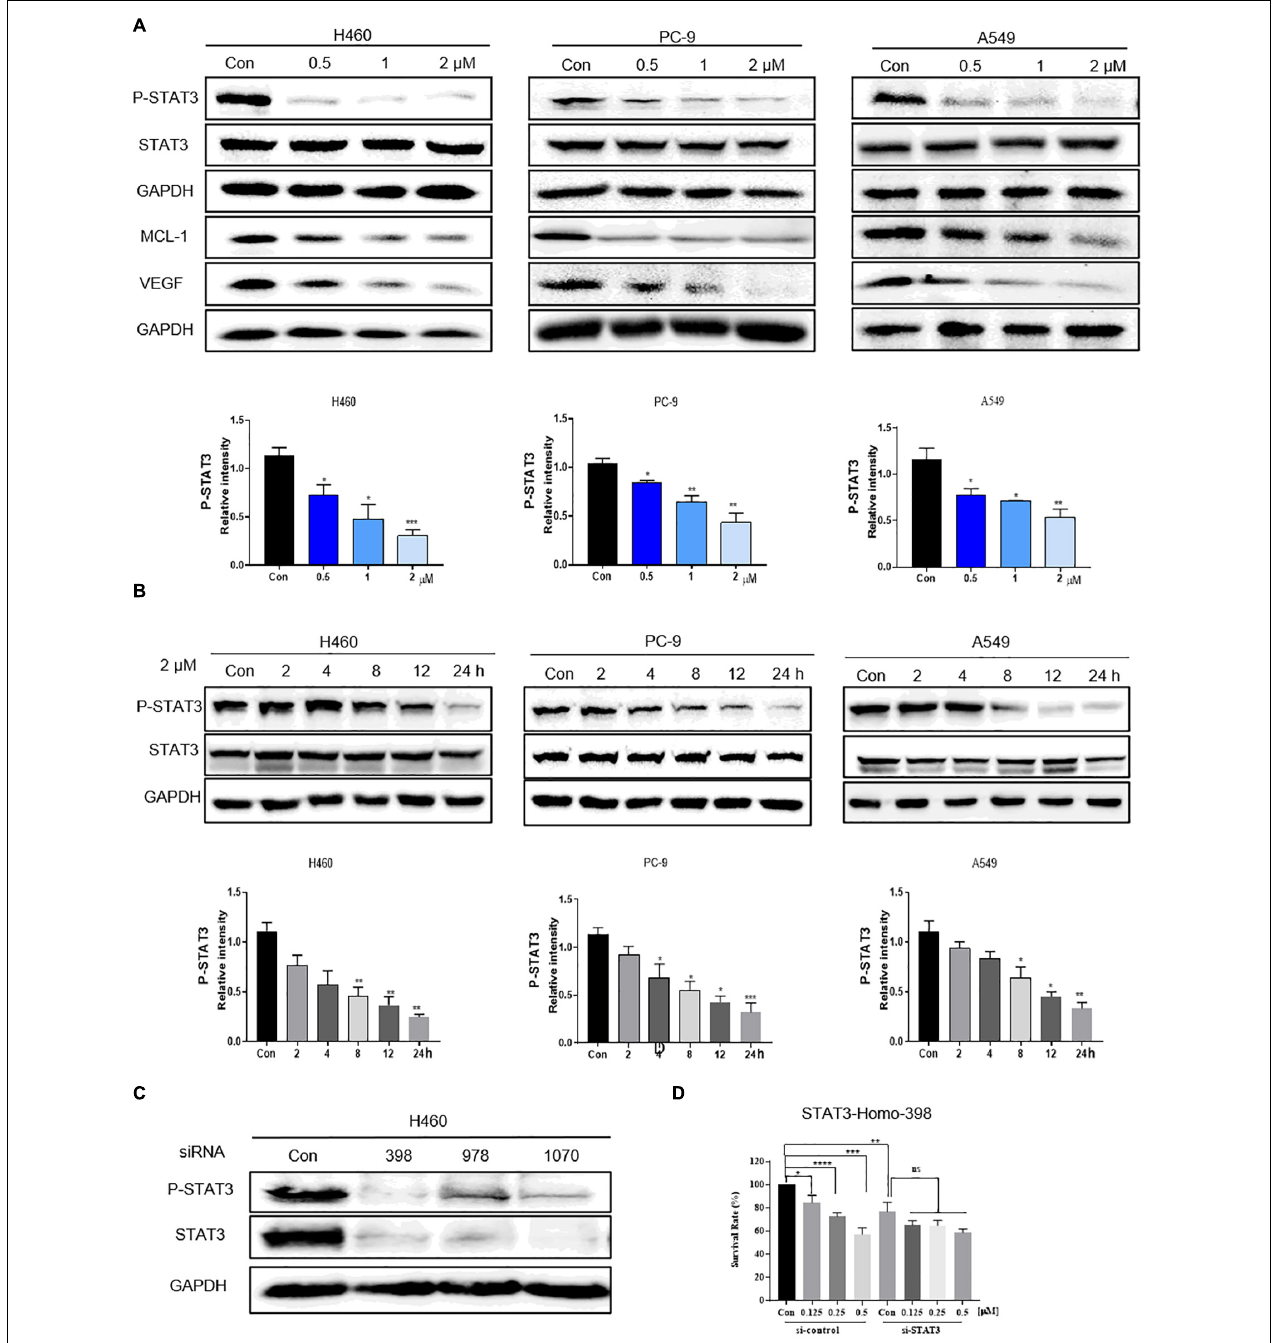
FIGURE 3 | Flubendazole inhibited the STAT3 signaling pathway. (A) Expression levels of p-STAT3, STAT3, VEGF, and MCL-1 based on western blotting assays. (B) Flubendazole (2 µ M) inhibited P-STAT3 in a time-dependent manner. (C) Expression of p-STAT3 and STAT3 detected by western blotting in H460 cells transfected using si-NC or si-STAT3 (si398, si978, and si1070) for 48 h. (D) Inhibitory effects of flubendazole on the proliferation of H460 cells after transfection with si-NC or si-STAT3 (si398). GAPDH as a loading control. Outcomes are representative of three independent experiments (* P < 0.05, ** P < 0.01, *** P < 0.001, **** P <